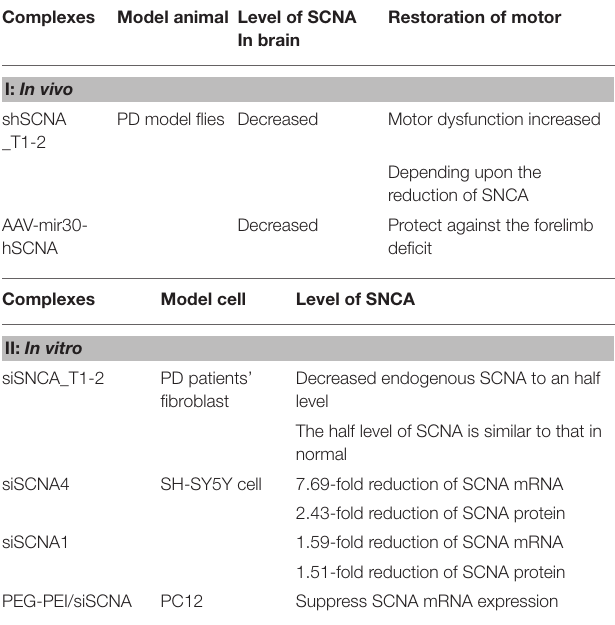
TABLE 2B | In vivo and In vitro study of RNA interference therapy for PD. Complexes Model animal Level of SCNA In